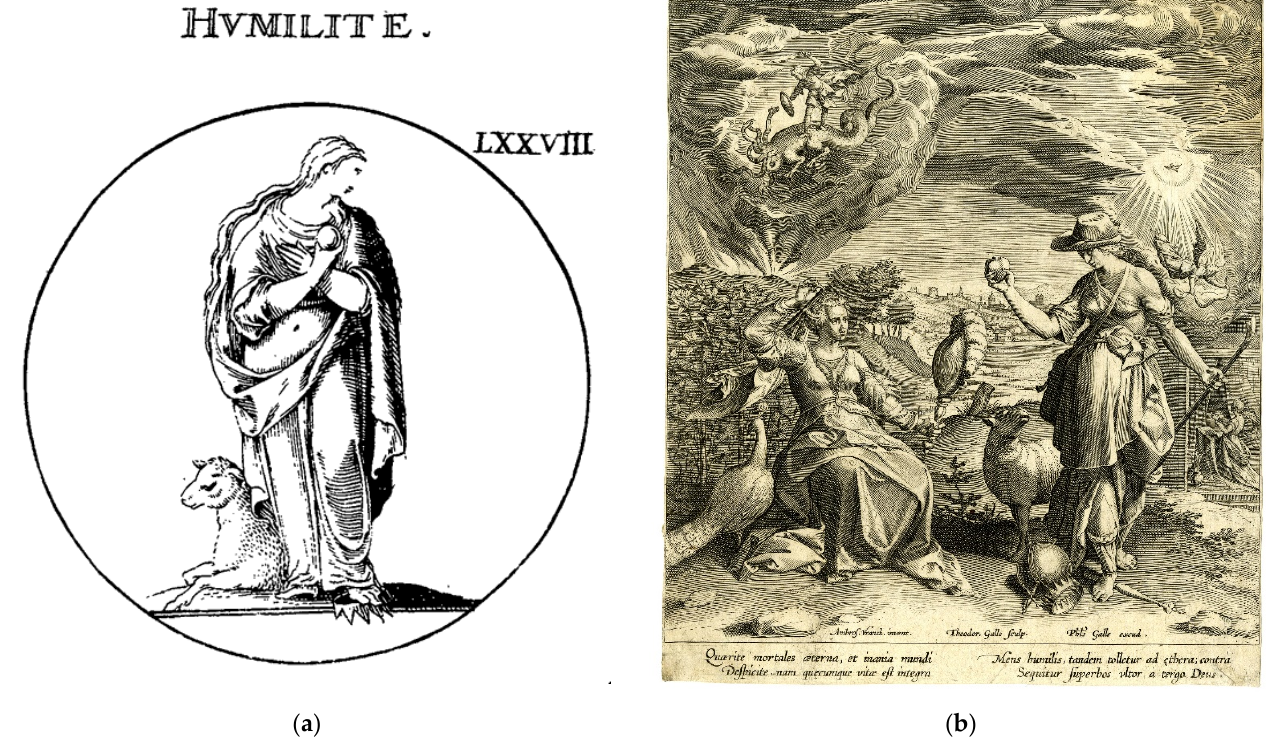
Figure 11. ( a ) Humility, Iconologia, 1643, Cesare Ripa, Paris; ( b ) Allegory of Pride and Humility , c. 1612–1633, London, British Museum, 1875,0710.2768.